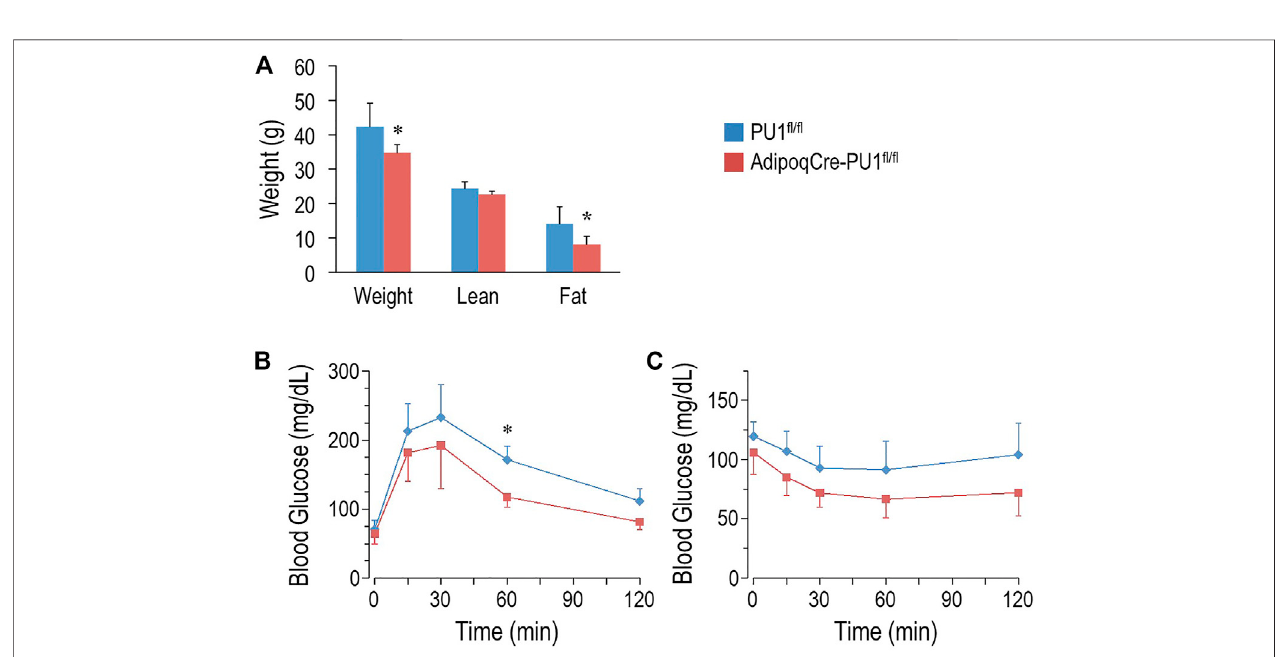
FIGURE 3 | Adipocyte PU.1 De fi ciency Protects Mice Against Age-Associated Obesity and Insulin Resistance. (A) Body weight (BW) and body composition of 10 months old male AdipoqCre-PU.1 fl / fl mice ( N (cid:1) 6)and the controllittermate PU.1 fl / fl mice ( N (cid:1) 6). (B) Forglucose tolerance test, 10months old male mice ( N (cid:1) 7vs. 5) werefastedovernightandinjectedwithglucose(2 g/kgbodyweight).Bloodglucosewasthenmeasured. (C) Forinsulintolerancetest,1 yearoldmalemice( N (cid:1) 8vs.7) were fasted for 4-hr and injected with insulin (1.0 IU/kg body weight). Blood glucose was measured afterwards. * p < 0.05.